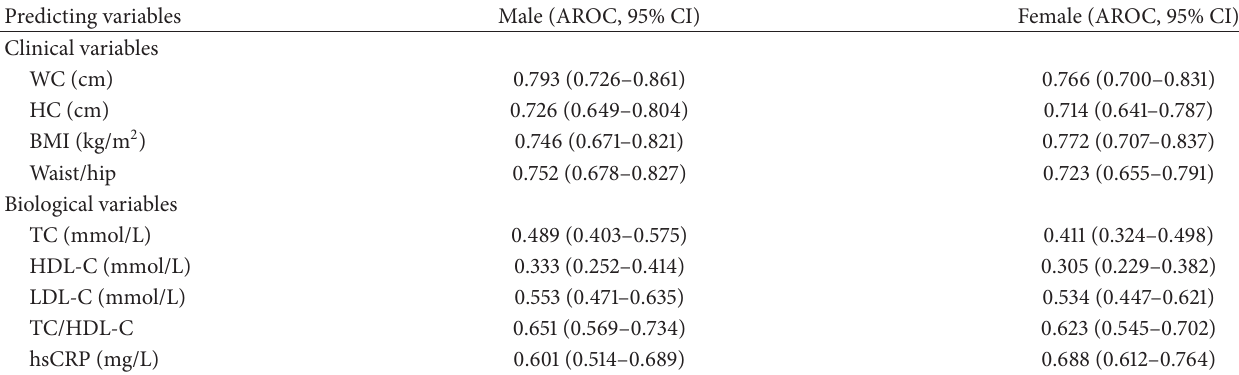
Table 3: Area under receiver operating characteristic curves for potential markers of insulin